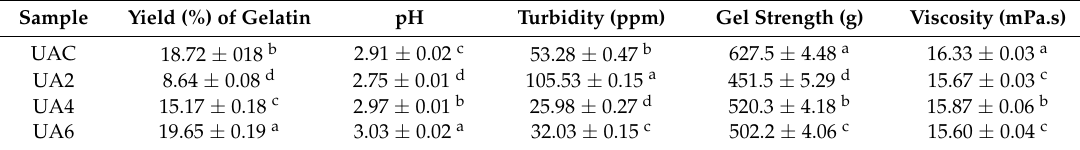
Table 1. Yields, pH, turbidity, gel strength and viscosity of gelatin extracted using ultrasound from bovine hide pretreated with enzyme actinidin. Values are presented as mean ± SE from triplicate